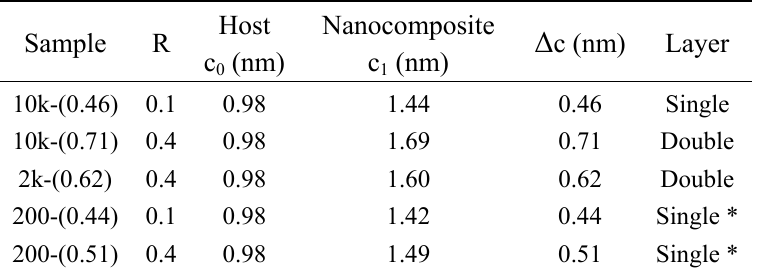
Table 1. Composition and interlayer distances of the